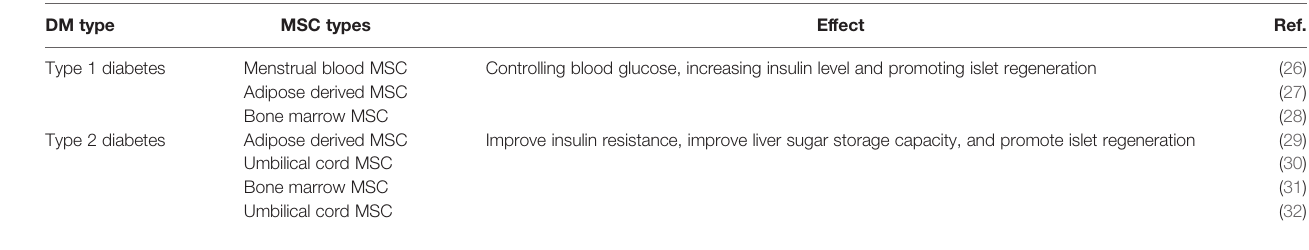
TABLE 1 | Mesenchymal stem cells (MSC) used in the treatment of diabetes mellitus (DM). DM type